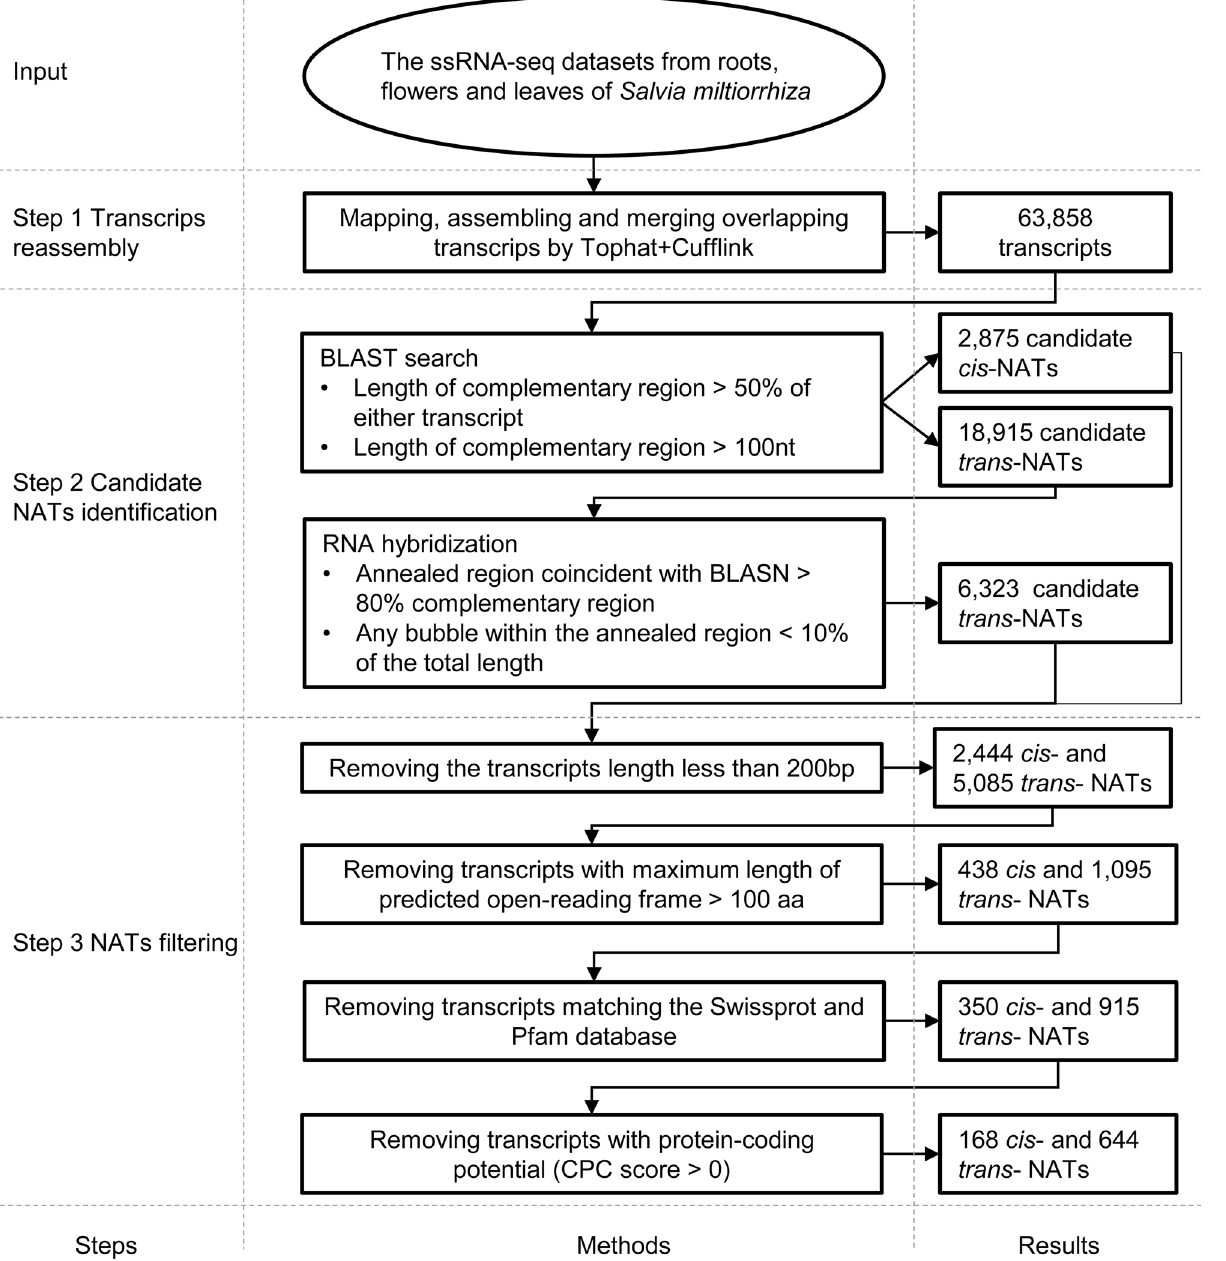
of antibiotics, biosynthesis of secondary metabolites, carbon metabolism, cutin, suberine and wax biosynthe- sis, cyanoamino acid metabolism, lipoic acid metabolism, metabolic pathways, phenylpropanoid biosynthesis, plant-pathogen interaction, propanoate metabolism, protein processing in the endoplasmic reticulum, purine metabolism, pyrimidine metabolism, riboflavin metabolism, RNA polymerase I, starch and sucrose metabolism and valine, leucine, and isoleucine degradation (Table S4).